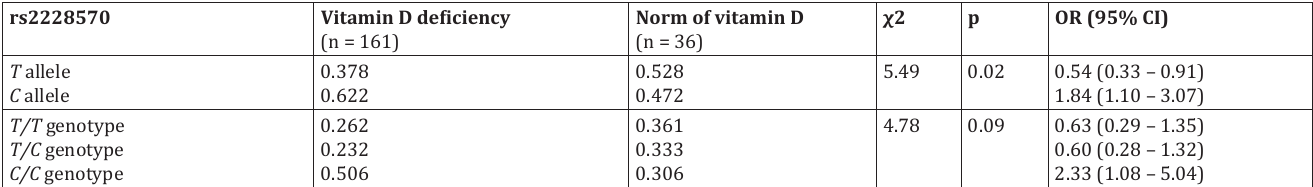
Frequency distribution of genotypes and alleles of the VDR rs1544410 depending on the level of vitamin D